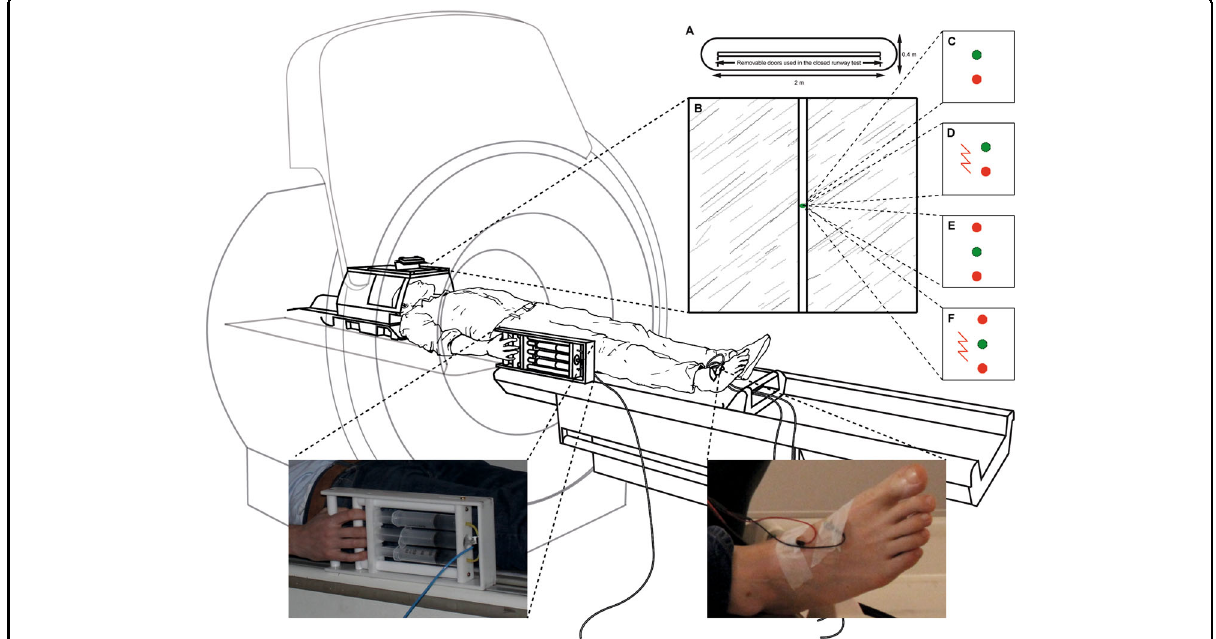
Fig. 1 The ethoexperimental approach to measuring the intensity of threat-avoidance behaviour. a The Mouse Defense Test Battery. b The Joystick Operated Runway Task. A force-sensing interface controls the speed of a green dot cursor pursued along a runway by a red dot cursor capable of in fl icting electric shock. The task comprised 12 trials each of pursuit ( c ), pursuit plus threat of electric shock ( d ), goal con fl ict ( e ), goal con fl ict plus threat of electric shock ( f ). Illustration by Nick